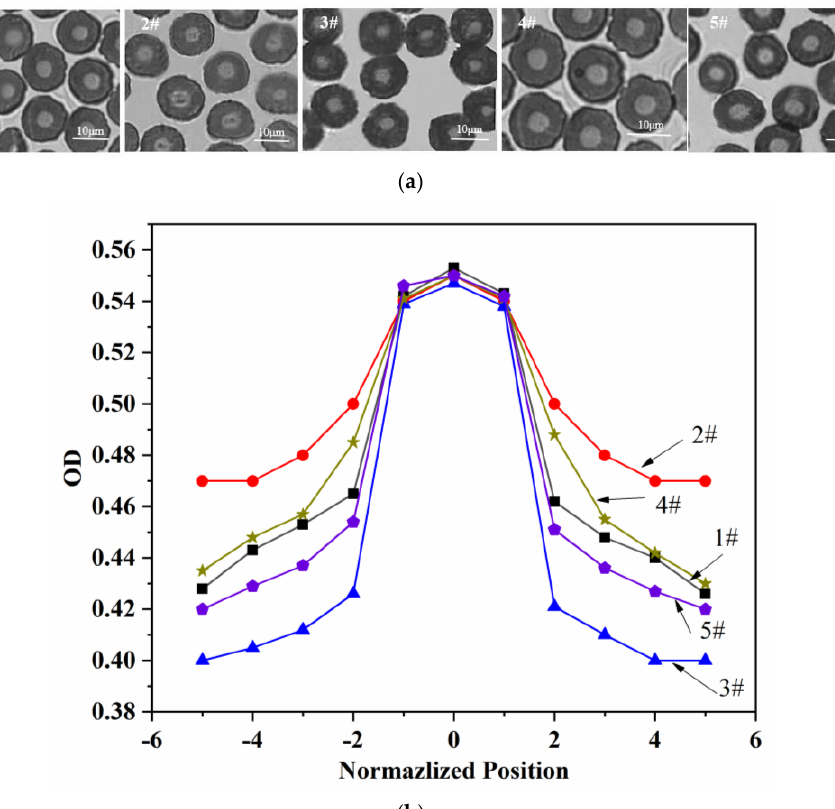
Figure 9. The translucency of the cross-section of the fine denier PAN pre-oxidized fiber by optical microscope of ( a ) cross-sectional transmittance images (Note, the diameter of each filament for pre-oxidized fiber was about 11 µ m) and ( b ) optical